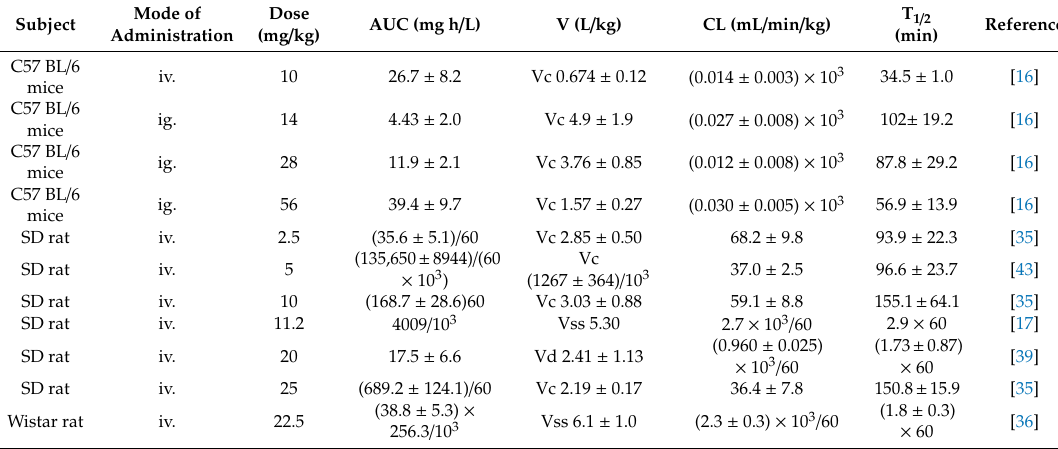
Table 1. Pharmacokinetics profiles of